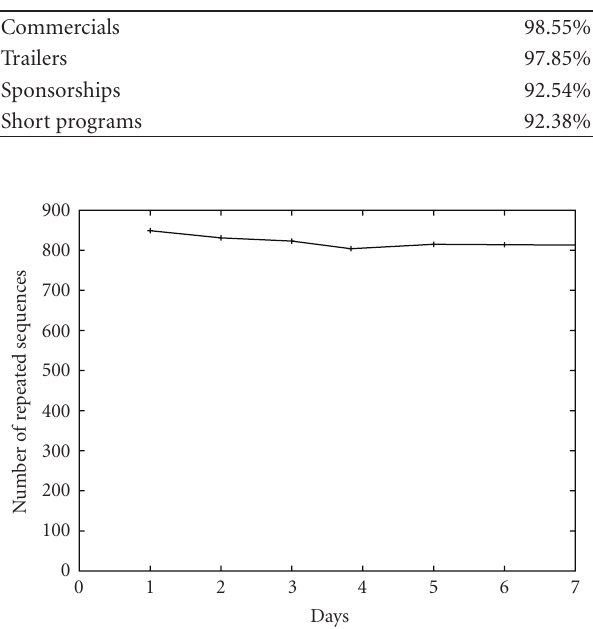
Figure 12: Variation of the number of detected repeated sequences.